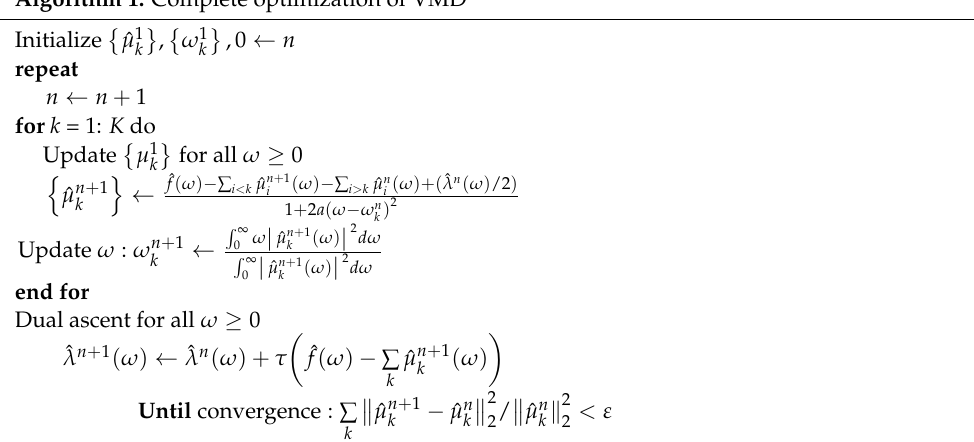
Algorithm 1: Complete optimization of